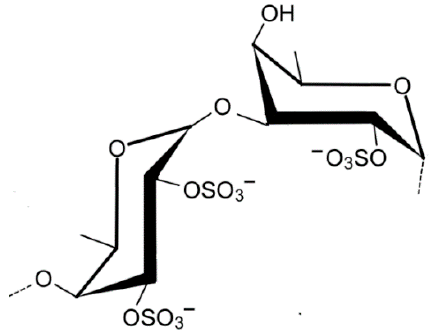
Figure 6. Idealized structure of the chemical units of fucoidan.